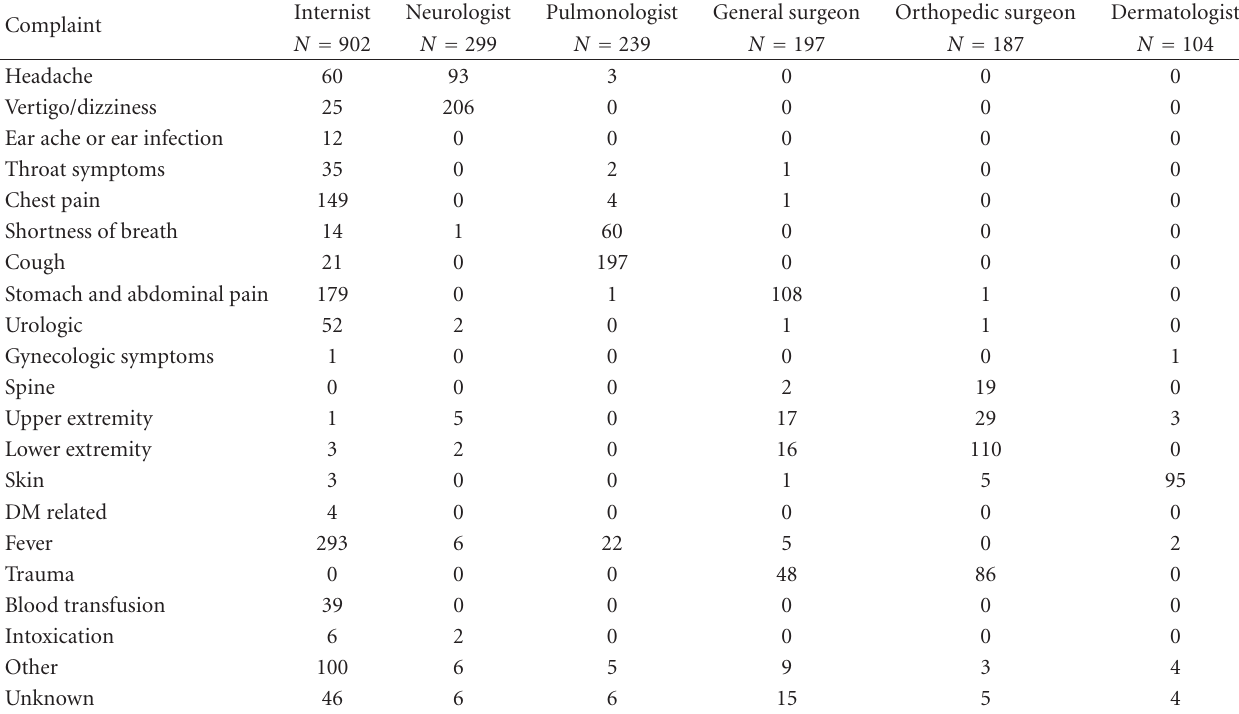
Table 2: Frequencies of complaints for the six most commonly consulted disciplines.